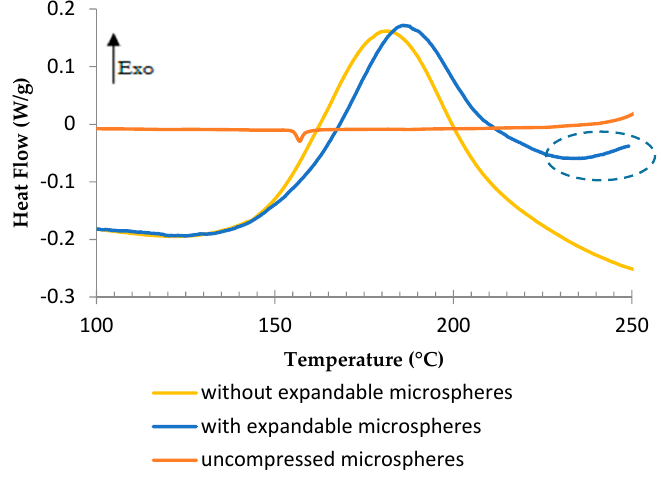
Figure 18. DSC analyses of compressed microspheres and TETM/DDS formulation with and without expandable microspheres, under air, at a heating rate of 3 °C/min.